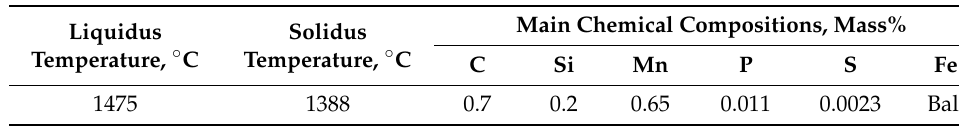
Table 1. Specification of studied alloys, wt.%.